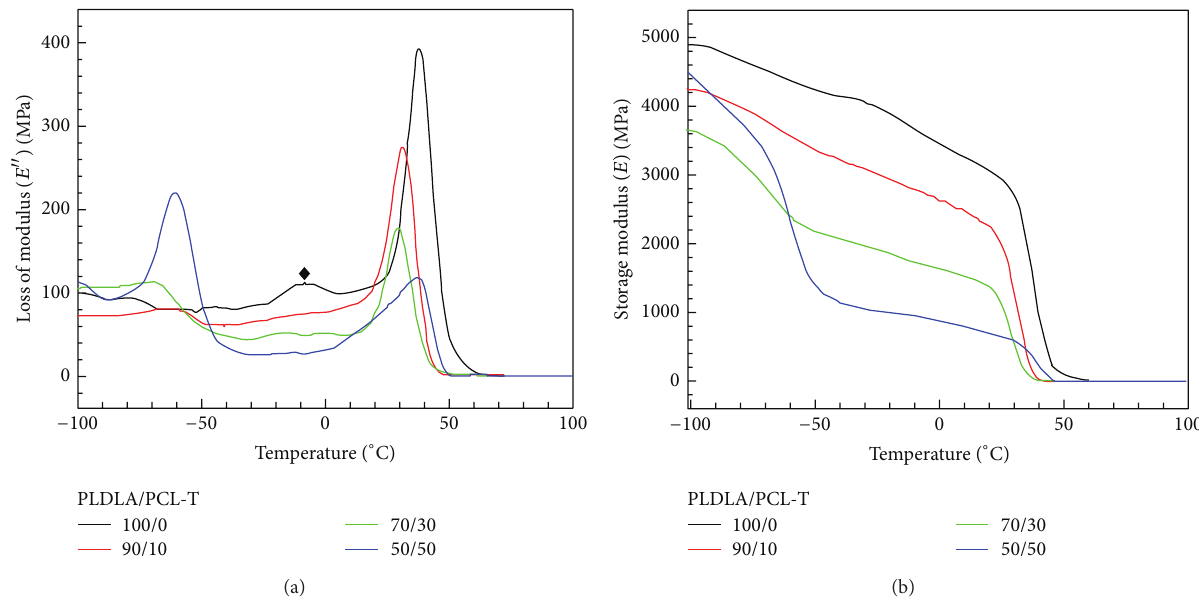
Figure 2: DMA curves for membranes containing PLDLA/PCL-T blends of 100/0, 90/10, 70/30, and 50/50. Panel (a): loss of modulus versus temperature ( 𝐸 󸀠󸀠 versus 𝑇 ); panel (b): storage modulus versus temperature ( 𝐸 󸀠 versus 𝑇 ).